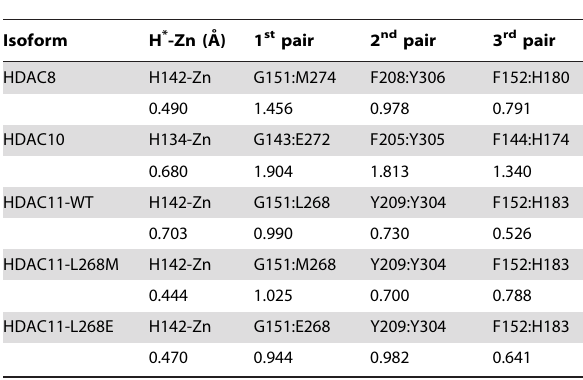
Table 4. The average distance values between important active site components in all isoforms measured during last 2 ns of the 5 ns long simulations.